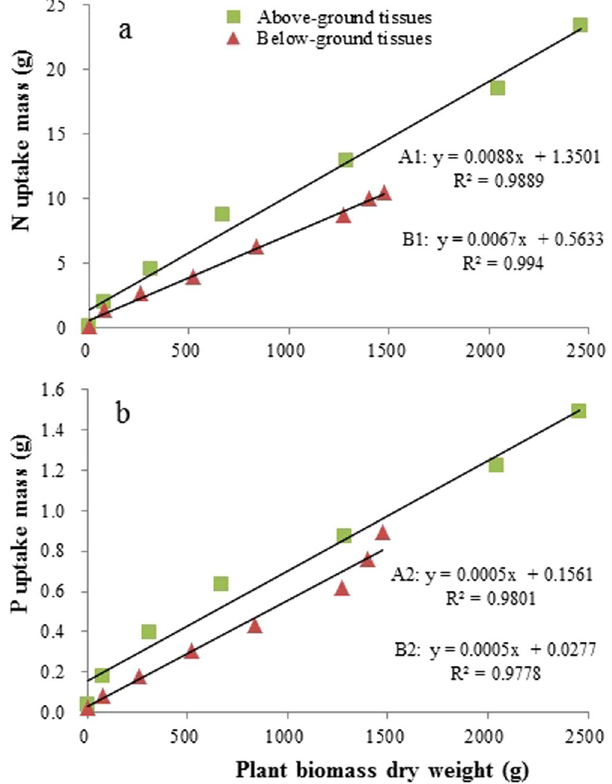
Figure 4. Correlation between nutrients uptake by T. dealbata and plant biomass dry weight, ( a ) N uptake mass, ( b ) P uptake mass, (A1) equation between N and above ground tissues, (A2) equation between P and above ground tissues, (B1) equation between N and below ground tissues, (B2) equation between P and below ground